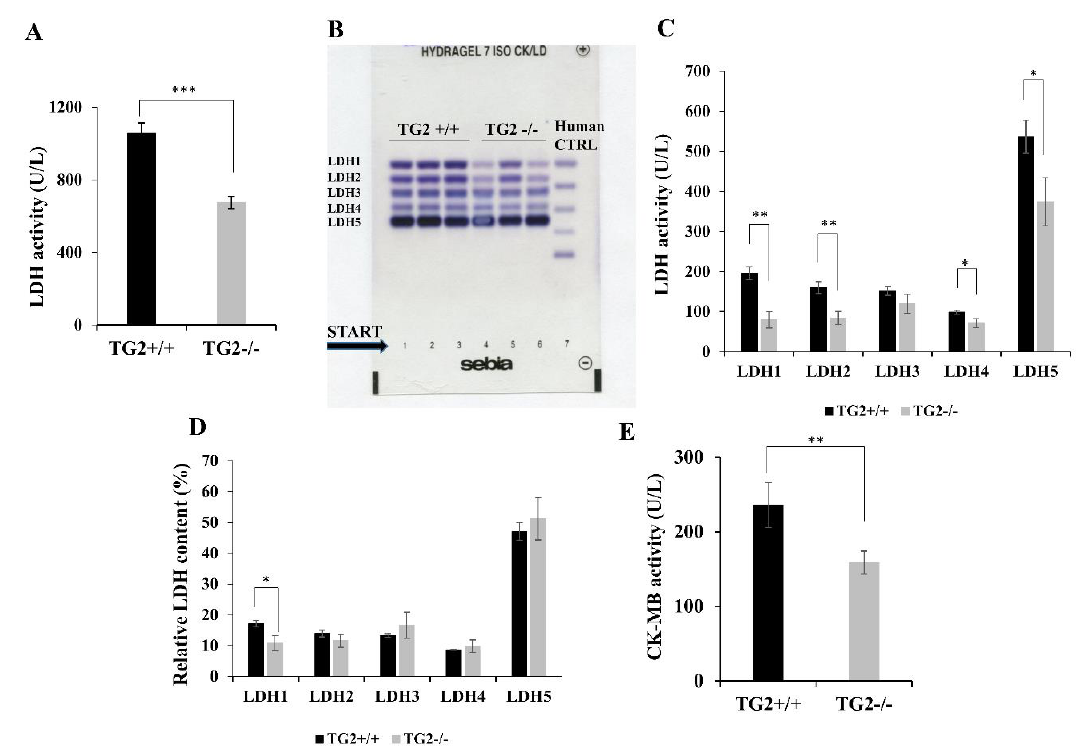
Figure 5. Phenylephrine treatment results in a lower degree of tissue damages reflected in changes